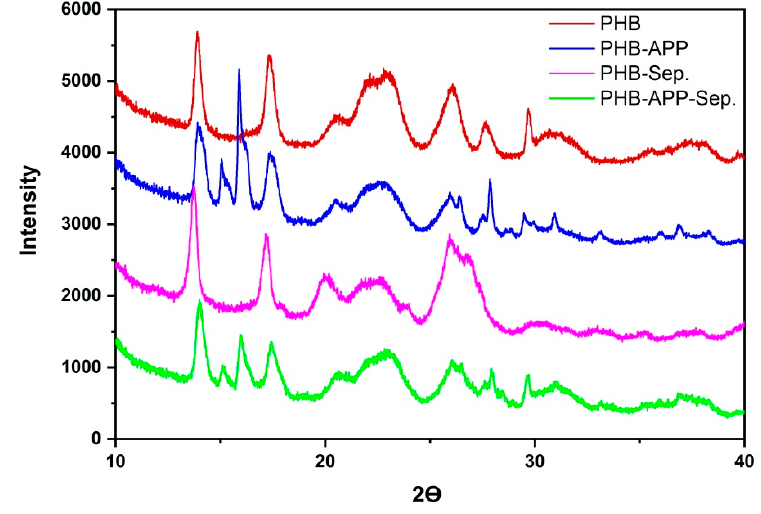
Figure 5. XRD patterns obtained from PHB; PHB-APP; PHB-Sep.; PHB-APP-Sep. Table 5. XRD peaks of PHB and blends.